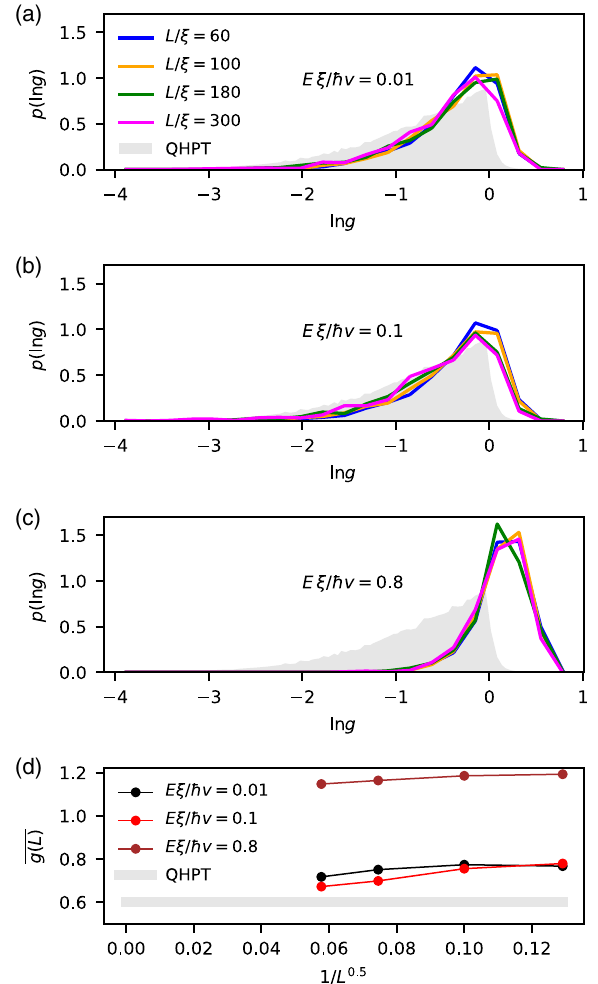
FIG. 5. Landauer conductance g (in units of e 2 =h ) of square samples of length L for the topological class AIII surface model with two Dirac nodes ( ν ¼ 2 ), as in Fig. 4. The probability distribution p ð ln g Þ of the logarithm of the conductance for L= ξ ¼ 60 , 100, 180, 300 is depicted in (a) – (c) for energies E ξ = ℏ v ¼ 0 . 01 , 0.1, 0.8, respectively. The data are based on between 3000 and 600 disorder realizations, depending on system size. The gray filled area depicts the result obtained for a square-shaped Chalker-Coddington network model of size 128, reproduced from Ref. [39]. Panel (d) shows the scaling of the mean square conductance g ð L Þ for the above lengths and energies and the asymptotic value for the QHPT obtained from Ref. [40]. For the horizontal axis, the exponent on L has been chosen Figs. 5(a) – 5(c), and the evolution of the average conduct- ance g ð L Þ with L is depicted in Fig. 5(d). The situation is similar to the ν ¼ 1 case. While small energies E ξ = ℏ v ¼ 0 . 01 , 0.1 result in distributions and average square conductances visibly approaching the QHPT case, at higher energy E ξ = ℏ v ¼ 0 . 8 the relevant length scale for this process exceeds our available system size and only a slight trend of the average conductance is visible.